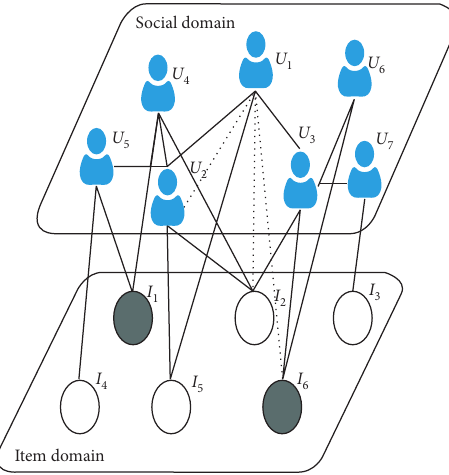
Figure 1: Hierarchical representation of heterogeneous social networks. The users ( U masked nodes in the network G